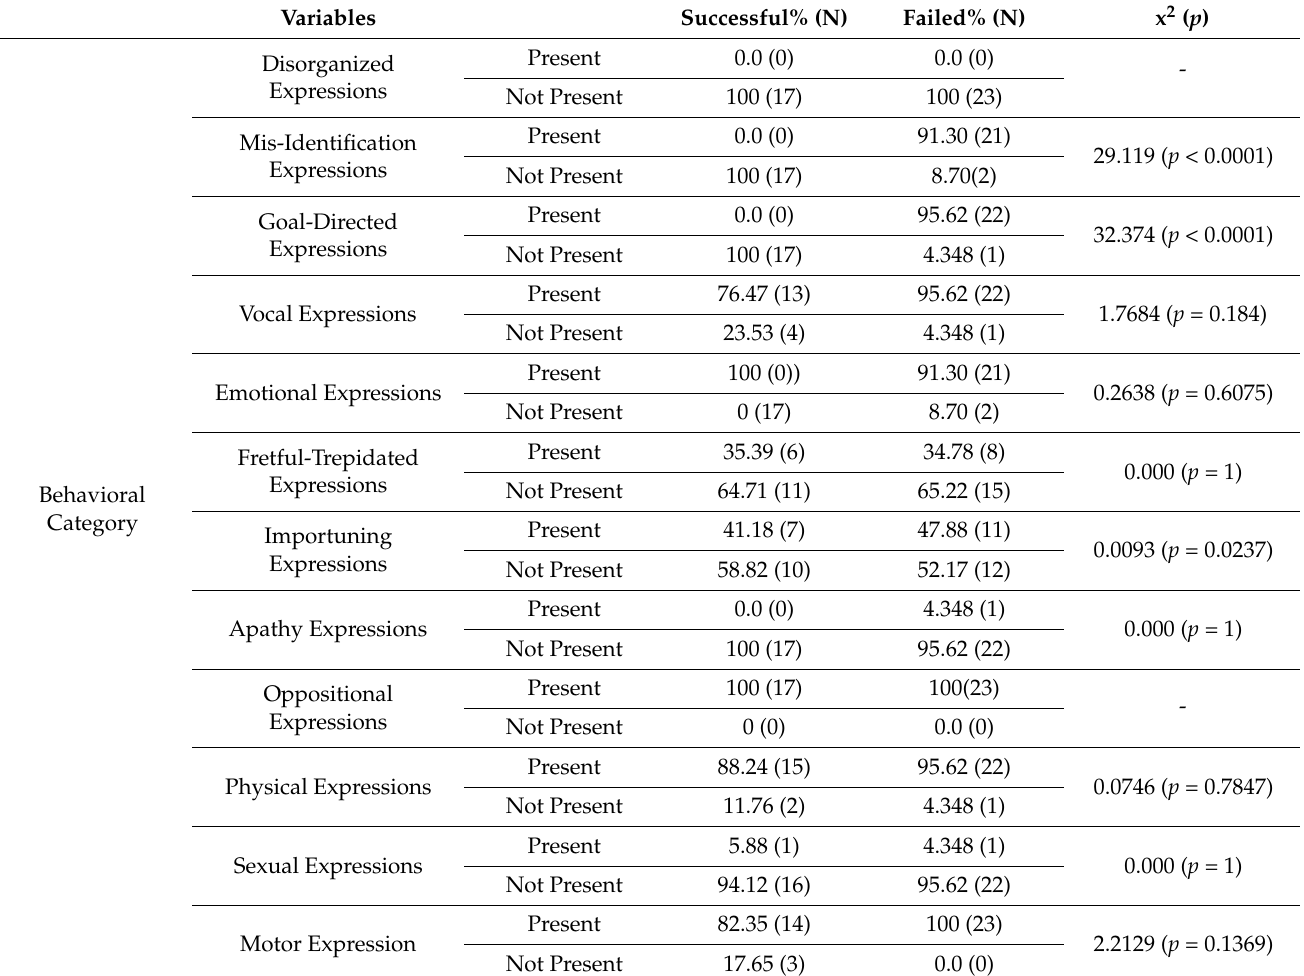
Table 6. Chi-square Test of Relationship between Behavior Category and Successful